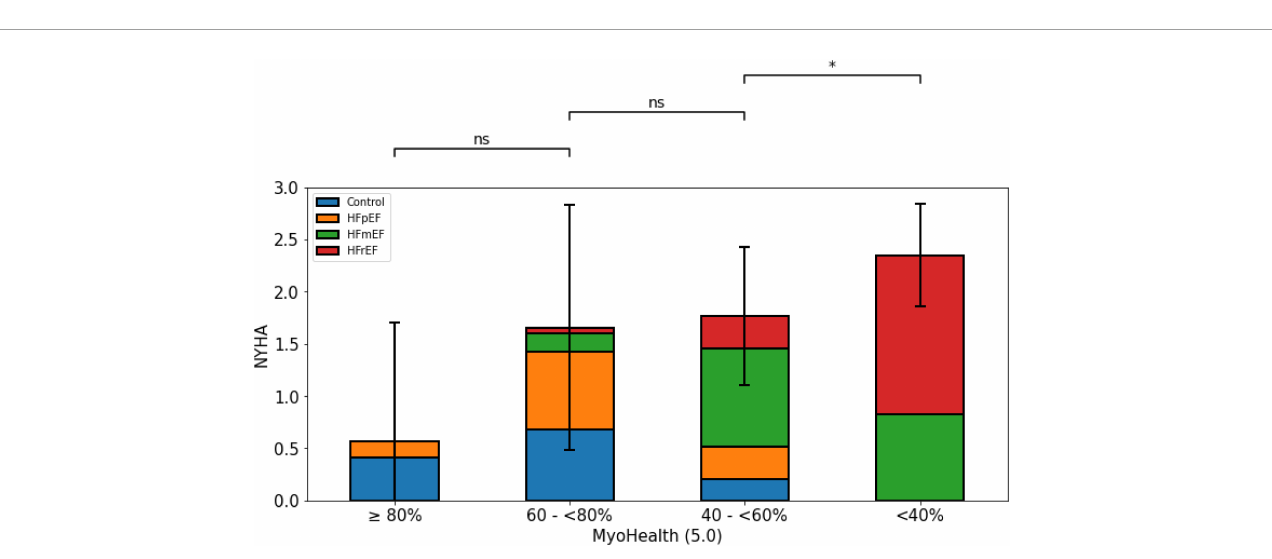
FIGURE4 Limitations and symptom burden by NYHA functional class across MyoHealth groups. MyoHealth ≥ 80% vs. MyoHealth 60– < 80%: p = 0.15; MyoHealth 60– < 80% vs. MyoHealth 40– < 60%: p = 1; MyoHealth 40– < 60% vs. MyoHealth < 40%: p < 0.01. ∗ Significant; ns, not